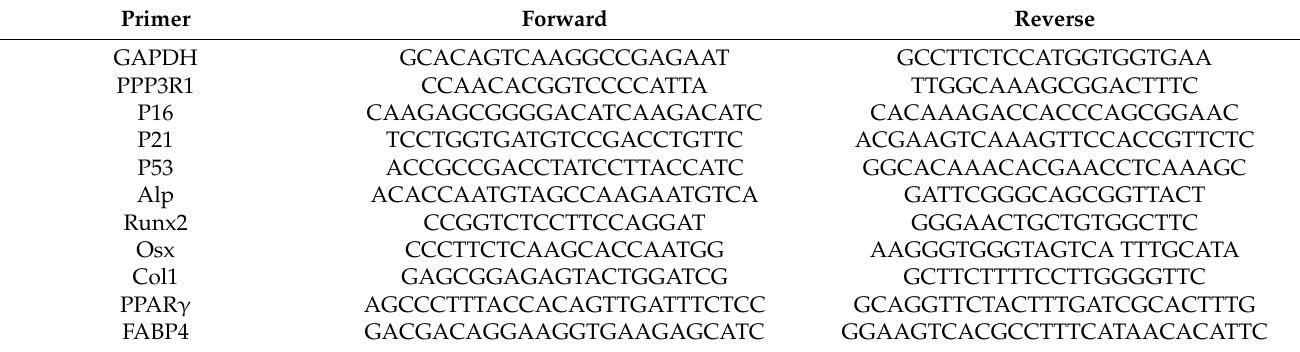
Table 1. Sequences of primers used for qRT-PCR